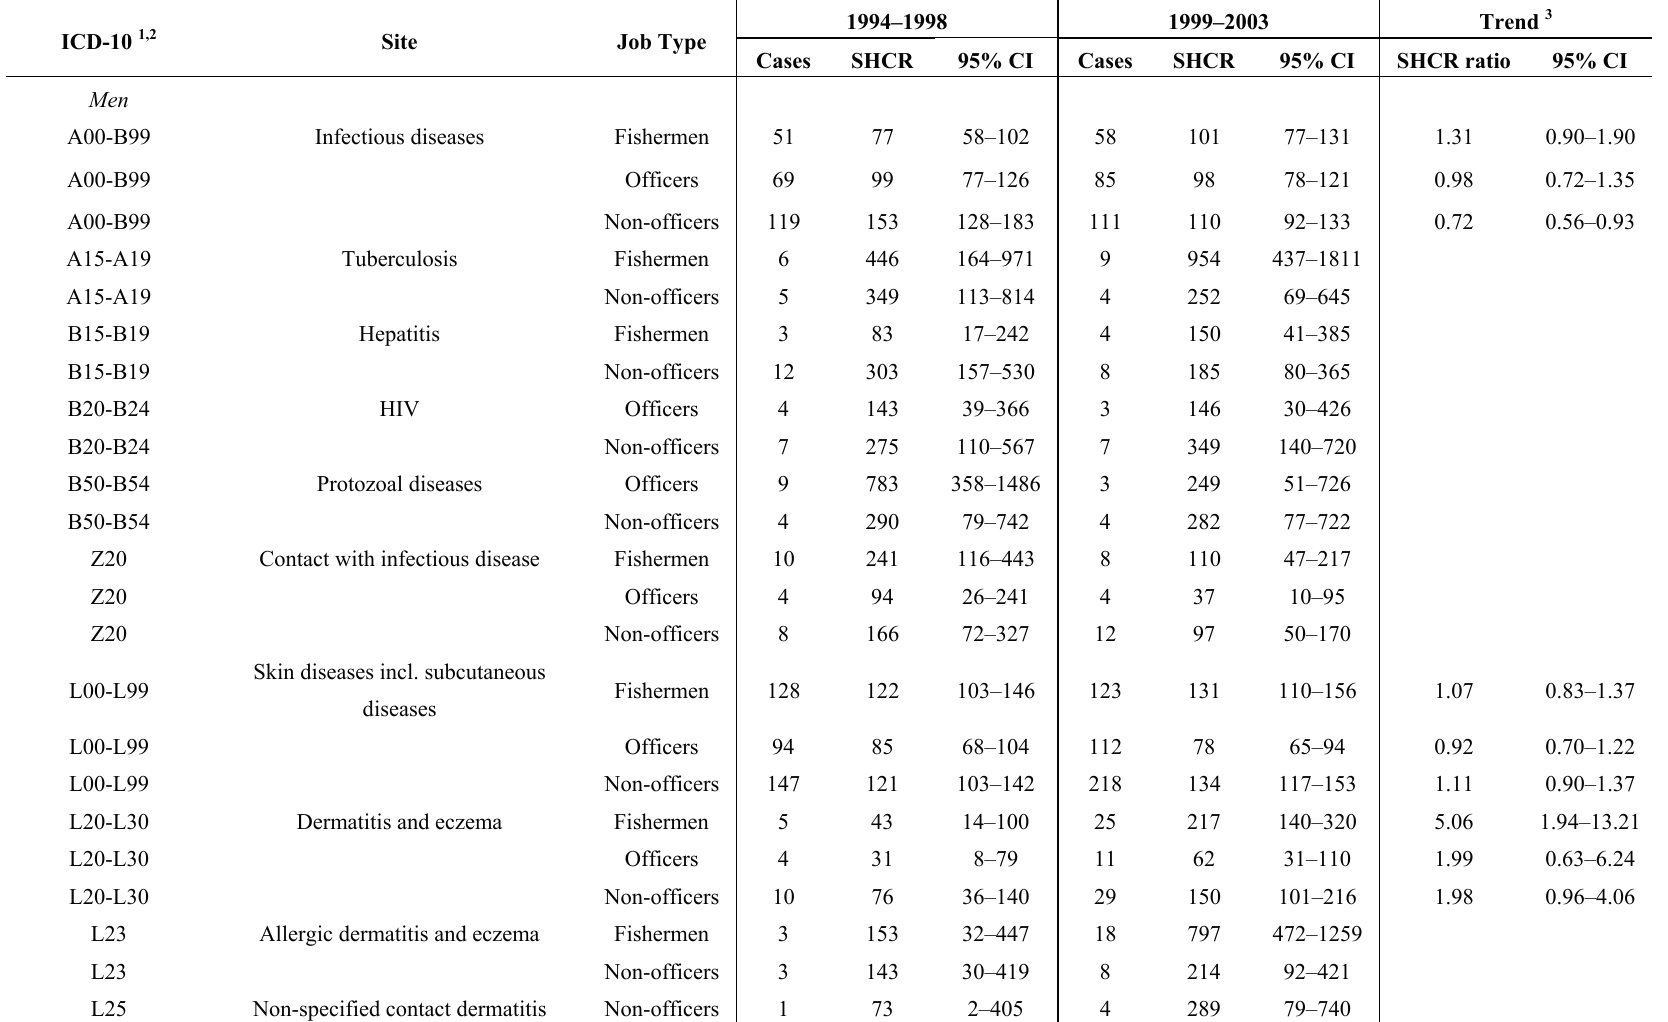
Table 4. Standardized hospital contact ratios (SHCR) for infectious diseases and skin diseases, 1994–2003, among Danish fishermen as a whole; and among officers and non-officer seamen by time